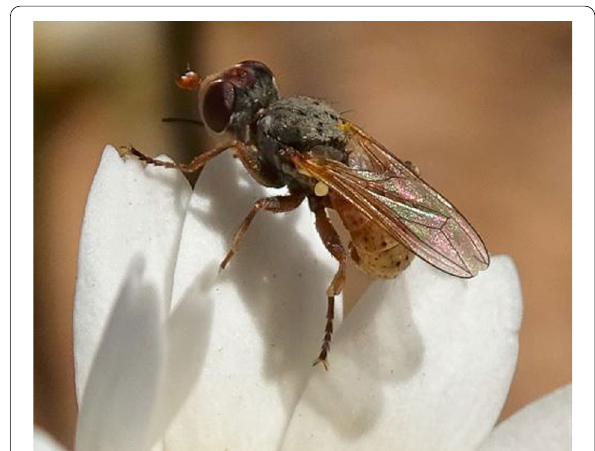
Fig. 7 Zodion erythrurum Rondani 1865 male